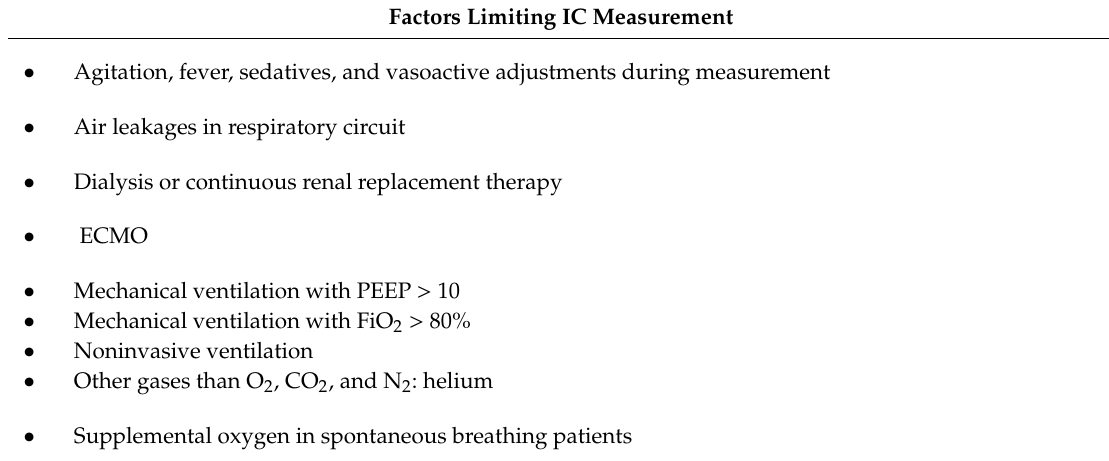
Table 3. Factors limiting the reliability and feasibility of IC